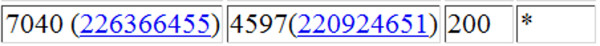
Example of annotation of a hypothetical protein using GeneOrder4.0. A row displaying computed paired similar proteins from the tabular output of GeneOrder4.0. The first column shows a protein belonging to Rhodococcus opacus and the second column shows a protein belonging to Methylobacterium nodulans. This match is a function of the default or user-entered threshold discrimination score, reflected in the third column, which shows the BLAT score. The fourth column indicates, by the presence of a "*", whether either of the proteins are annotated as hypothetical. Numbers in front of the links are the protein numbers, designated in numerical order from its Genbank entry, in the genome. By clicking the (underlined) links, GenBank files are displayed showing that the Rhodococcus opacus protein in the first column is annotated as hypothetical, while the Methylobacterium nodulans protein in the second column is annotated as a beta-lactamase domain protein.